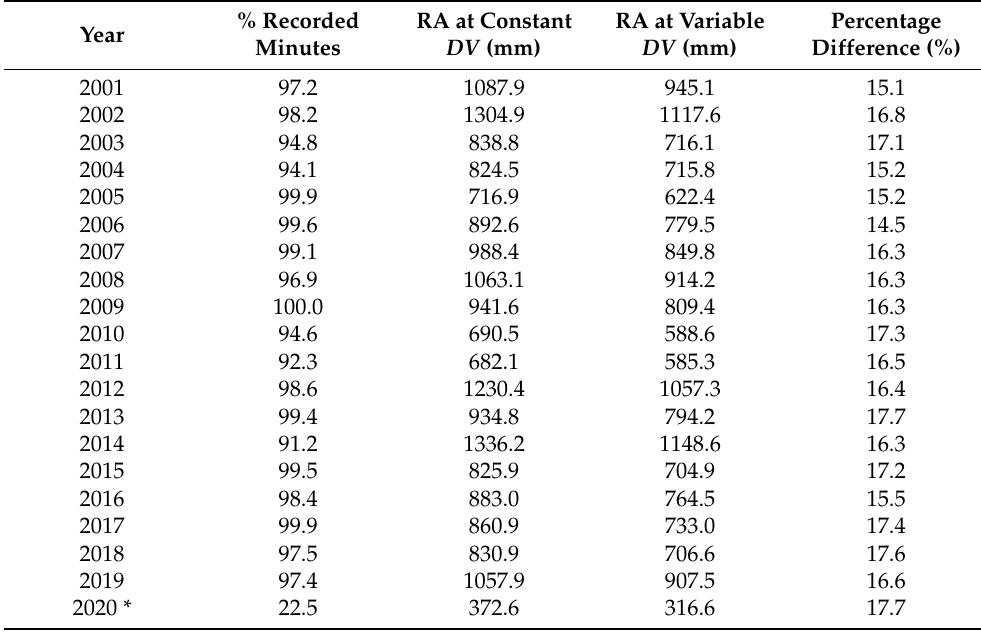
Table 5. Rainfall amount for the selected events recorded by the CRAL gauge at the CFARR field test site using a constant and a variable drop volume ( DV